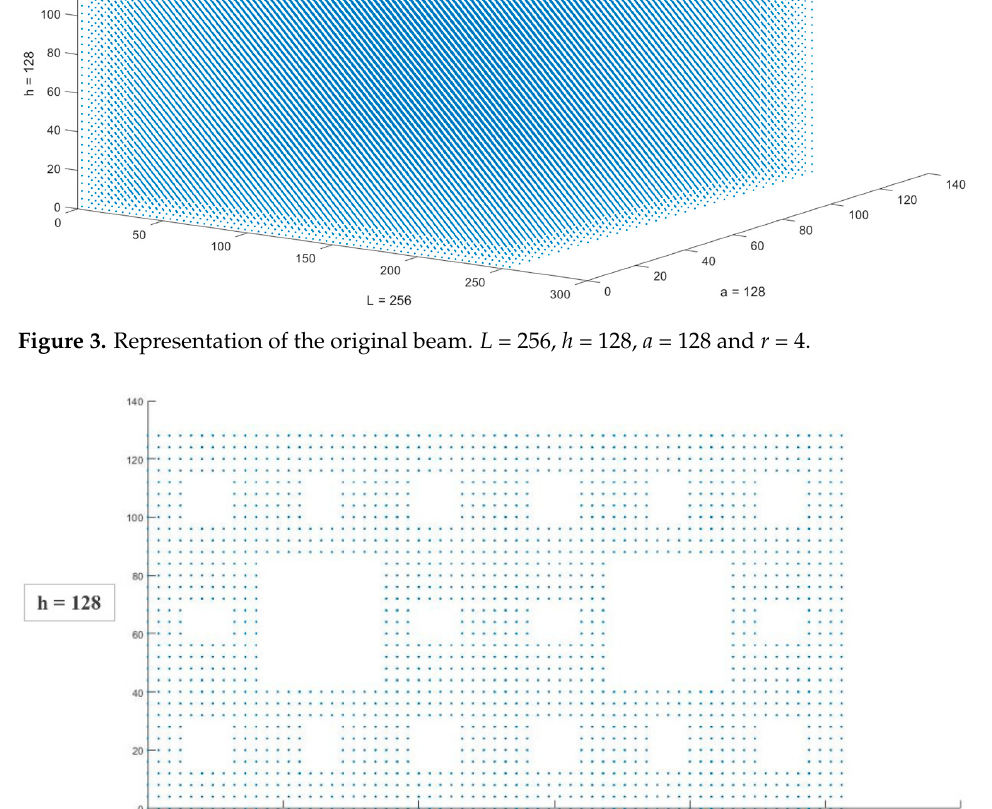
Figure 3. Representation of the original beam. L = 256, h = 128, a = 128 and r = 4.